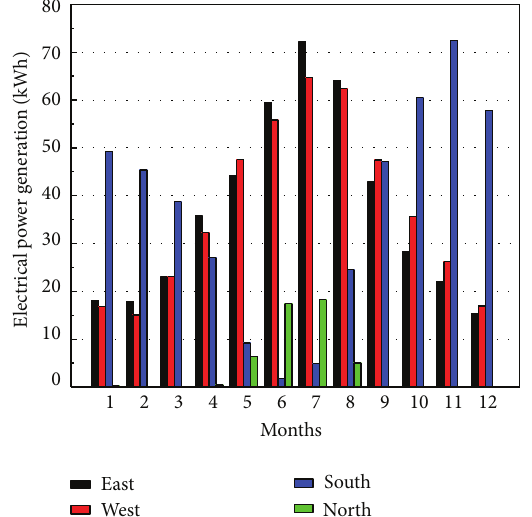
Figure 11: The monthly electrical output (kWh) of the BIPV for the building model facing in all four directions.